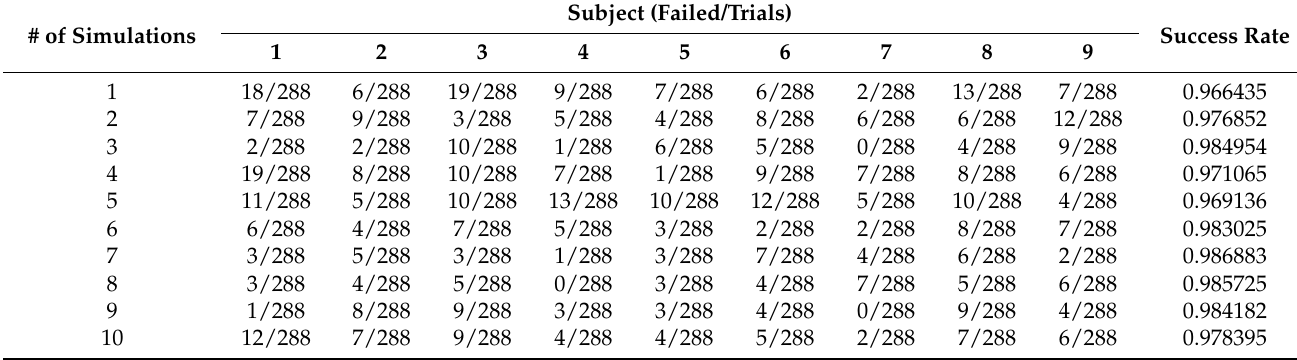
Table 5. Accuracy results of classification for 10 simulations, with changing random seeds uniformly in